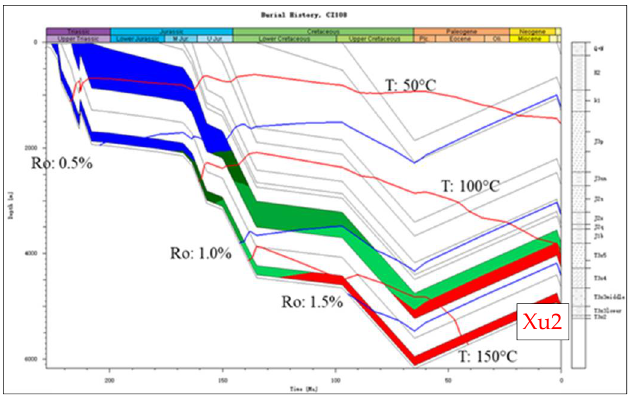
Figure 9. Burial history of the Xu2 member in Western Sichuan Basin.